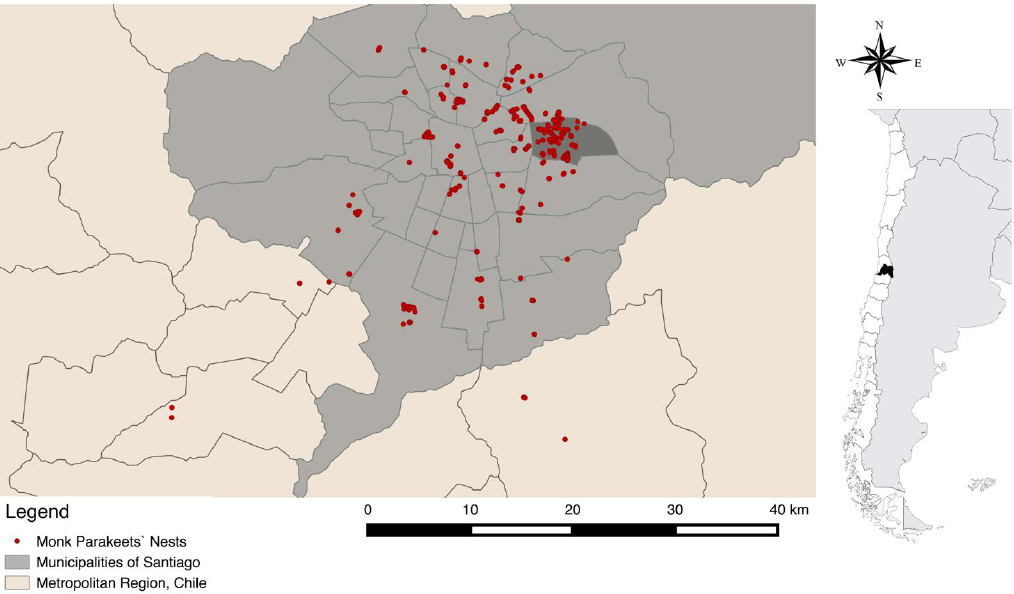
Figure 1. Study area in the Metropolitan Region of Chile (right inset). Dark central area is Santiago Metropolis and darker municipality is La Reina. Red dots mark 546 trees with 1458 Monk Parakeet’s nests, located in 25 municipalities between 2016 and 2019.